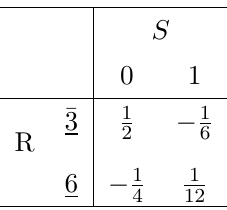
Table 4 . The relative factors of the colour-colour spin-spin interaction within the diquark in equation (B.1) for various color irreps and spin.